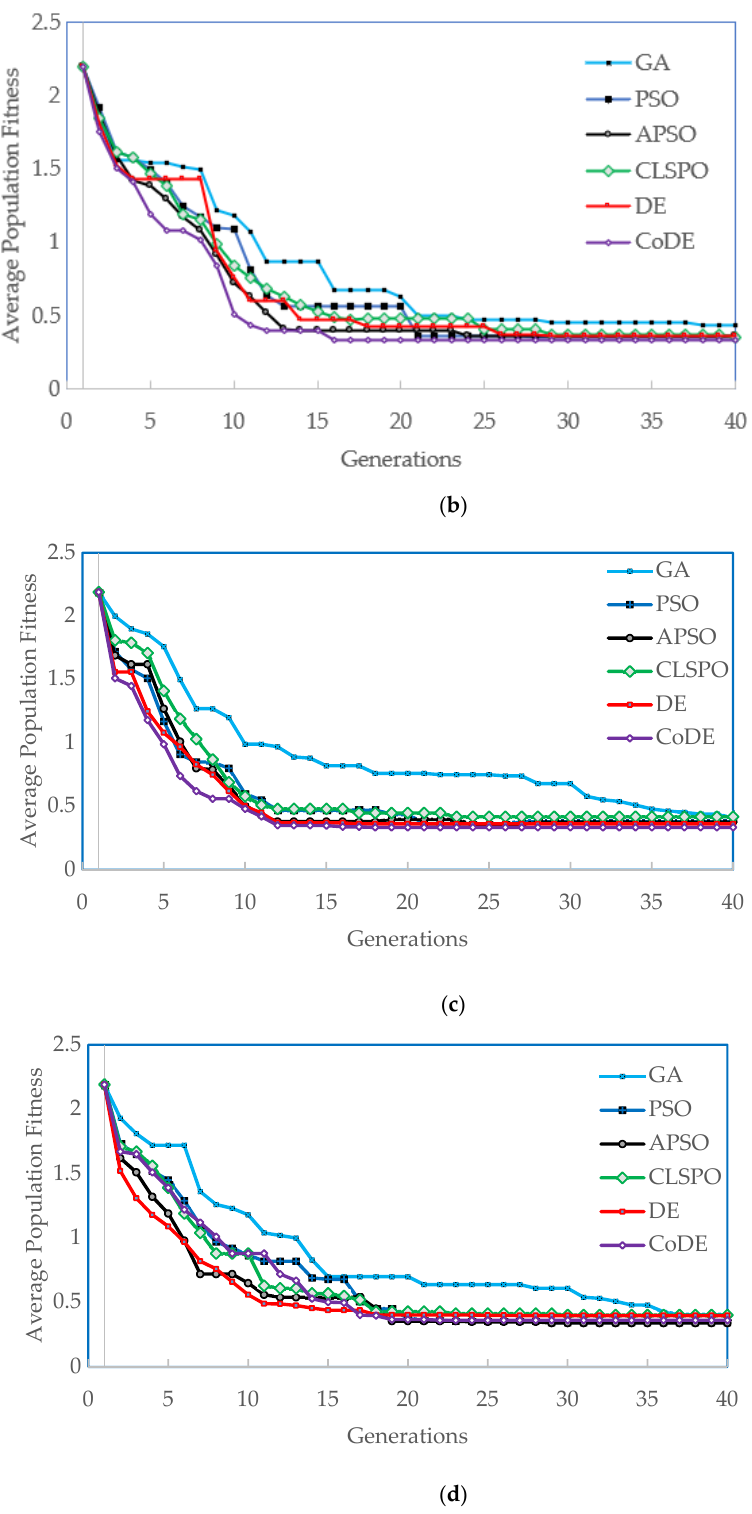
Figure 3. ( a ) Average population fitness as a function of the number of generations for ReliefF- BKMC. ( b ) Average population fitness as a function of the number of generations for RFE-BKMC. ( c ) Average population fitness as a function of the number of generations for ReliefF-BASC. ( d ) Average population fitness as a function of the number of generations for